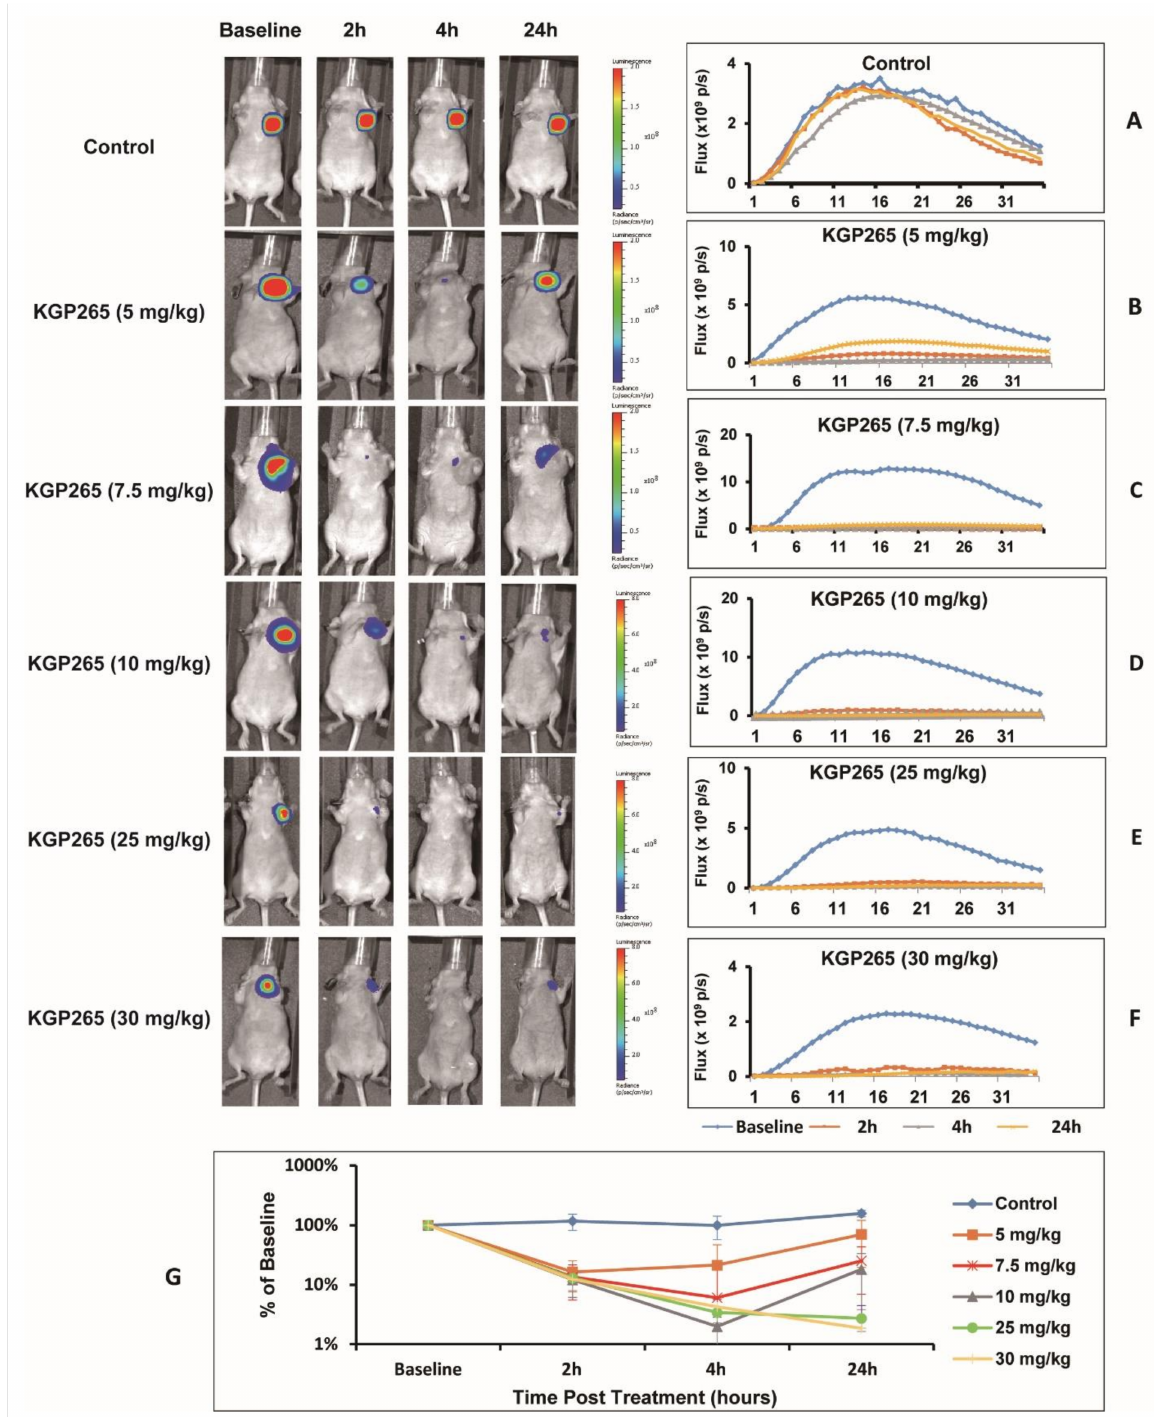
Figure 3. BLI observations of the MDA-MB-231-luc tumor dose response to KGP265. ( Left ) BLI signal intensity images overlaid as heat maps on gray-scale photographs of nude mice at about 12 min following the administration of luciferin at selected time points following the administration of various doses of KGP265. All intensity maps have the same heat scale. ( Right ) Corresponding BLI intensity curves for the respective individual mice on the left showing differential variations over a period of 35 min following the administration of luciferin at the baseline (blue), 2 h (orange), 4 h (grey) and 24 h (yellow) following each of the doses of KGP265: ( A ) saline control, ( B ) 5 mg/kg, ( C ) 7.5 mg/kg, ( D ) 10 mg/kg, ( E ) 25 mg/kg, ( F ) 30 mg/kg and ( G ) KGP265 dose response comparisons. Relative signals indicating differential dose responses over a period of 24 h following the administration of different doses of KGP265 to MDA-MB-231-luc tumor-bearing nude mice: